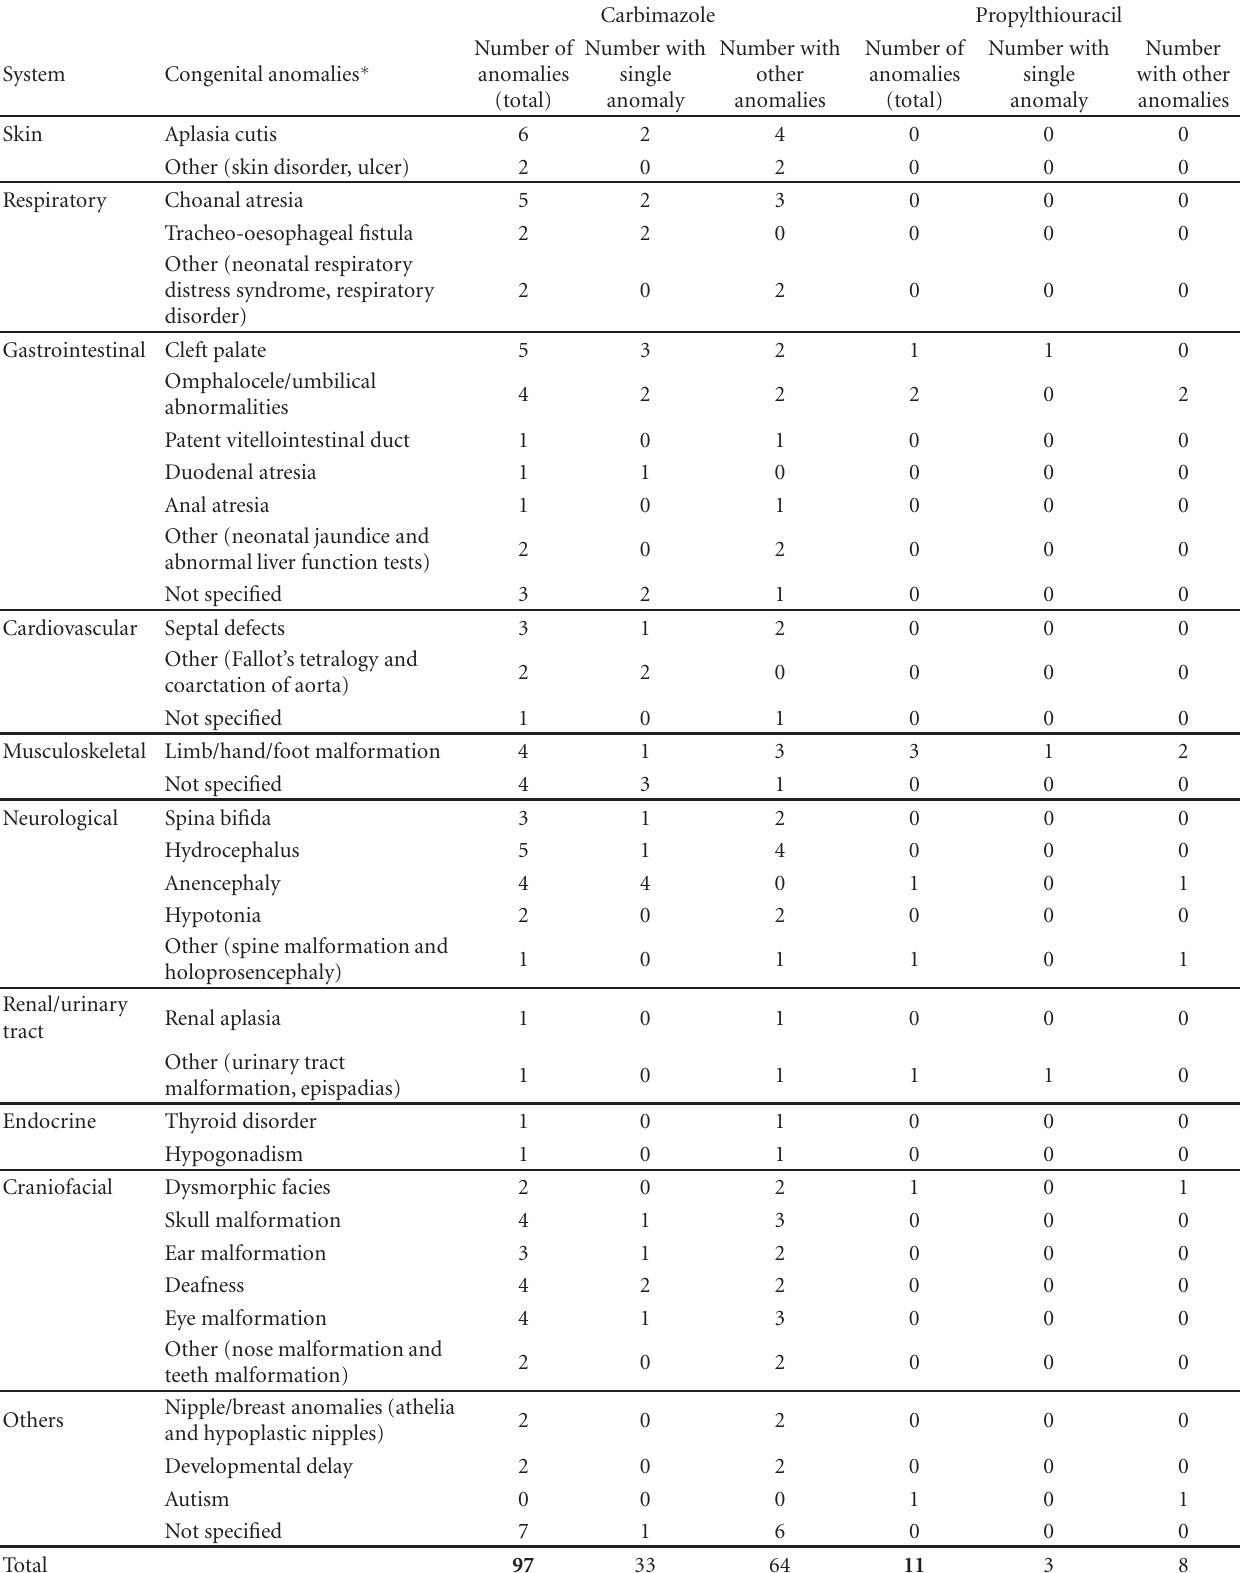
Table 1: Suspected adverse drug reactions of congenital anomalies associated with carbimazole and propylthiouracil received via the UK Yellow Card